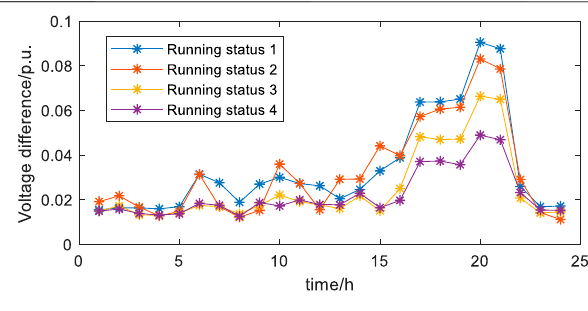
FIGURE 13 | Voltage levels for four running